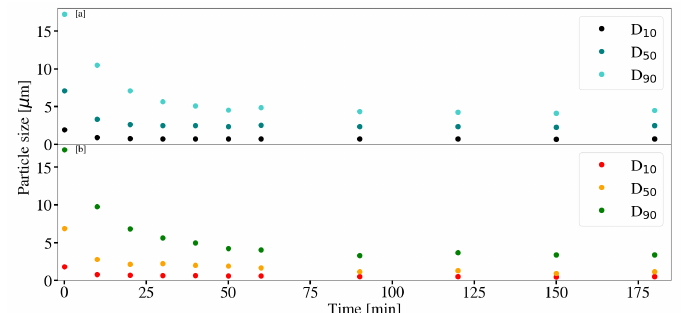
Figure 3. ( a ) Particle size measurements with time for Mg-Al LDH samples synthesised at a cooling water inlet temperature of 30 °C, with a change in retention time (S6). ( b ) Particle size measurements with time for Mg-Al LDH samples synthesised at a cooling water inlet temperature of 50 °C, with a change in retention time (S12). Milling parameters were set at a rotational speed of 2000 rpm, media size of 2 mm and a solids loading of 10%.